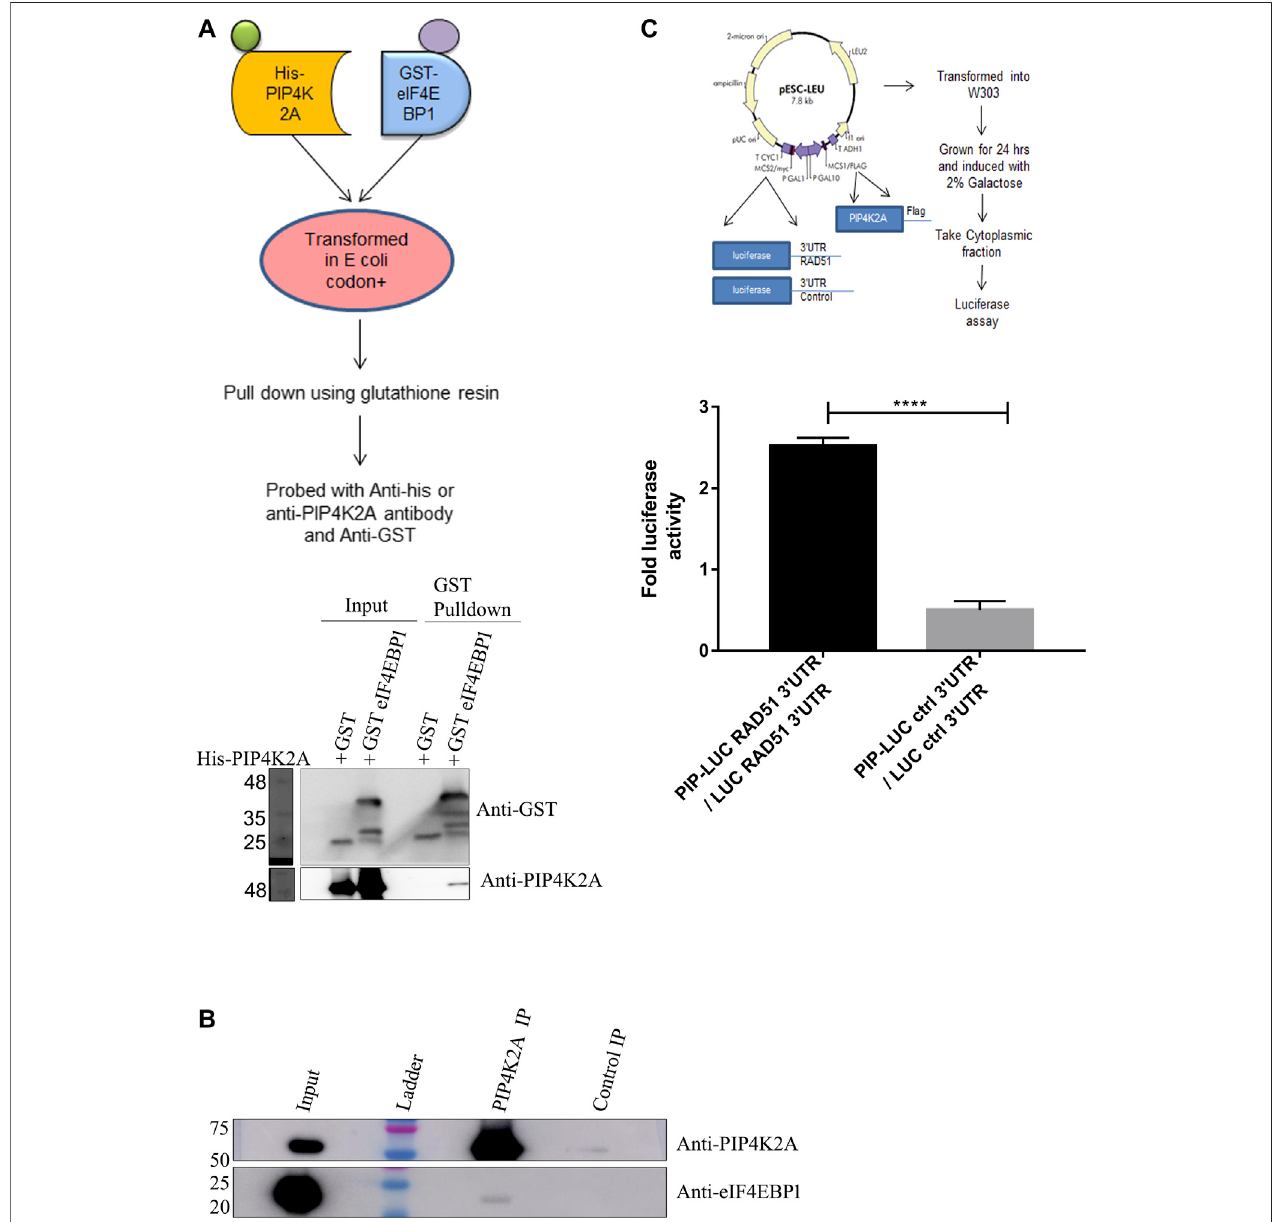
FIGURE 4| PIP4K2Aspeci fi cally interacts with eIF4EBP1 and regulates translation. (A) . His-PIP4K2A was co-transformed witheIF4EBP1-GST or only GST. Cells were then lysed, and pull-down was performed using glutathione resin. The eluates were then analyzed using SDS-PAGE and Western blotting with antibodies against GST or PIP4K2A ( n (cid:1) 3). (B) . HEK293 cell lysates were immunoprecipitated with anti-PIP4K2A antibody or control IgG, and the immunoprecipitates were analyzed by Western blotting ( n (cid:1) 3). The blots were probed with anti-PIP4K2A (upper panel) and eIF4EBP1 (lower panel). (C) . PIP4K2A along with fi re fl y luciferase containing eitherRAD513 ′ UTRorcontrol3 ′ UTRinpESCLeuvectorwastransformedintoaW303ayeaststrain.ThetransformedyeastcellsweregrowninLeuselectionmediaand inducedwithgalactose.Thecellswerethenlysed,andtheluciferaseactivitywasassessed usingSteady-GloLuciferaseassay.Luciferaseactivitywasnormalized forthe protein content, and the mean ( ± SEM) fold change in luciferase activity was plotted for luciferase-containing control UTR or Rad51 – 3 ′ UTR ( n (cid:1) 3; unpaired t -test, one- tailed, p <